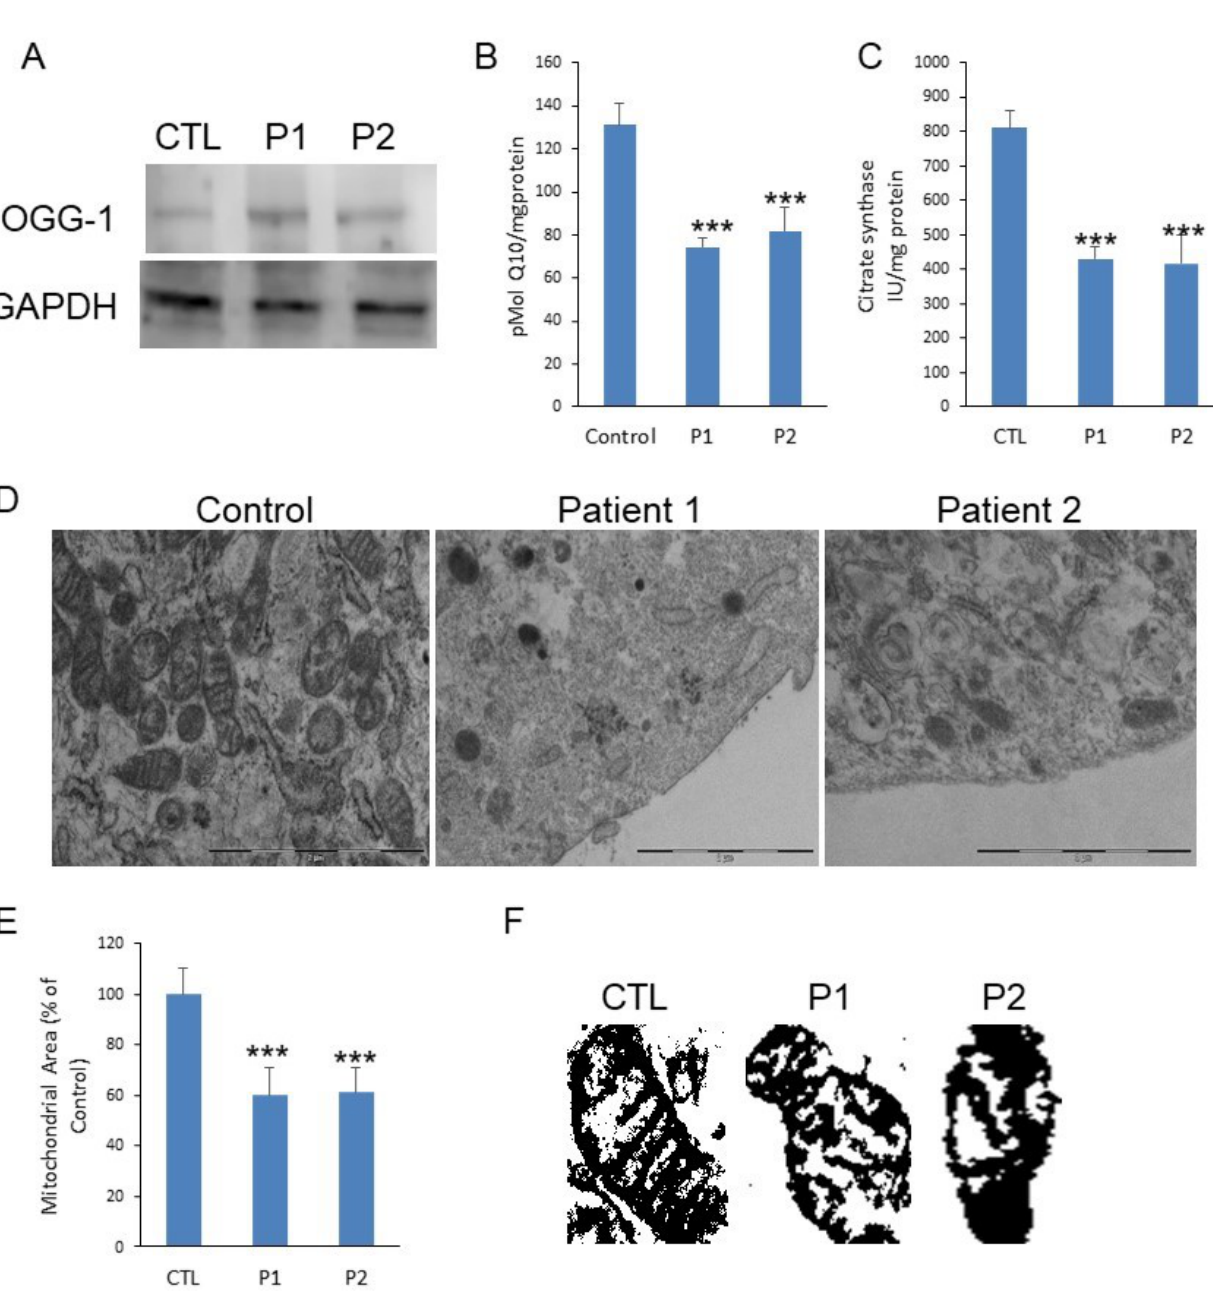
Figure 1. ( A ). Protein expression levels of OGG-1 were determined in Papillon-Lefevre Syndrome fibroblast cultures by Western blot analysis compared with a pool of two control subjects, as described in Materials and Methods. GAPDH was used as a loading control. ( B ). CoQ10 levels were measured by HPLC. Data represent the mean ± SD of three separate experiments. ( C ). Citrate Synthase specific activity in fibroblasts from PLS fibroblast compared with a pool of two healthy age-matched and sex-matched control subjects, was performed by enzymatic activity. Data represent the mean ± SD of three separate experiments. * p < 0.05; ** p < 0.01; *** p < 0.001 between control and PLS patients ( D ). Transmission electron microscopy of representative control fibroblasts showing mitochondria with typical ultrastructure and number and low number of mitochondria present in PLS fibroblasts with aberrant structure. Scale bar 2 µ m. ( E ). Mitochondrial area of PLS patients compared with control fibroblasts. ( F ). Representative masks of individual fibroblasts mitochondria from control and patients to show aberrant structure with alterations of